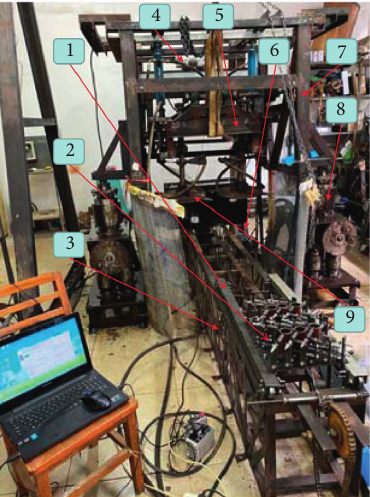
Figure 4: The SHEP. 1: the sugarcane-feeding device; 2: the sugarcane-clamping device; 3: the sugarcane-feeding pathway; 4: the actuating engine; 5: the cutter frame; 6: a vibration absorber; 7: the body frame; 8: the SSFE II; 9: a cutter.